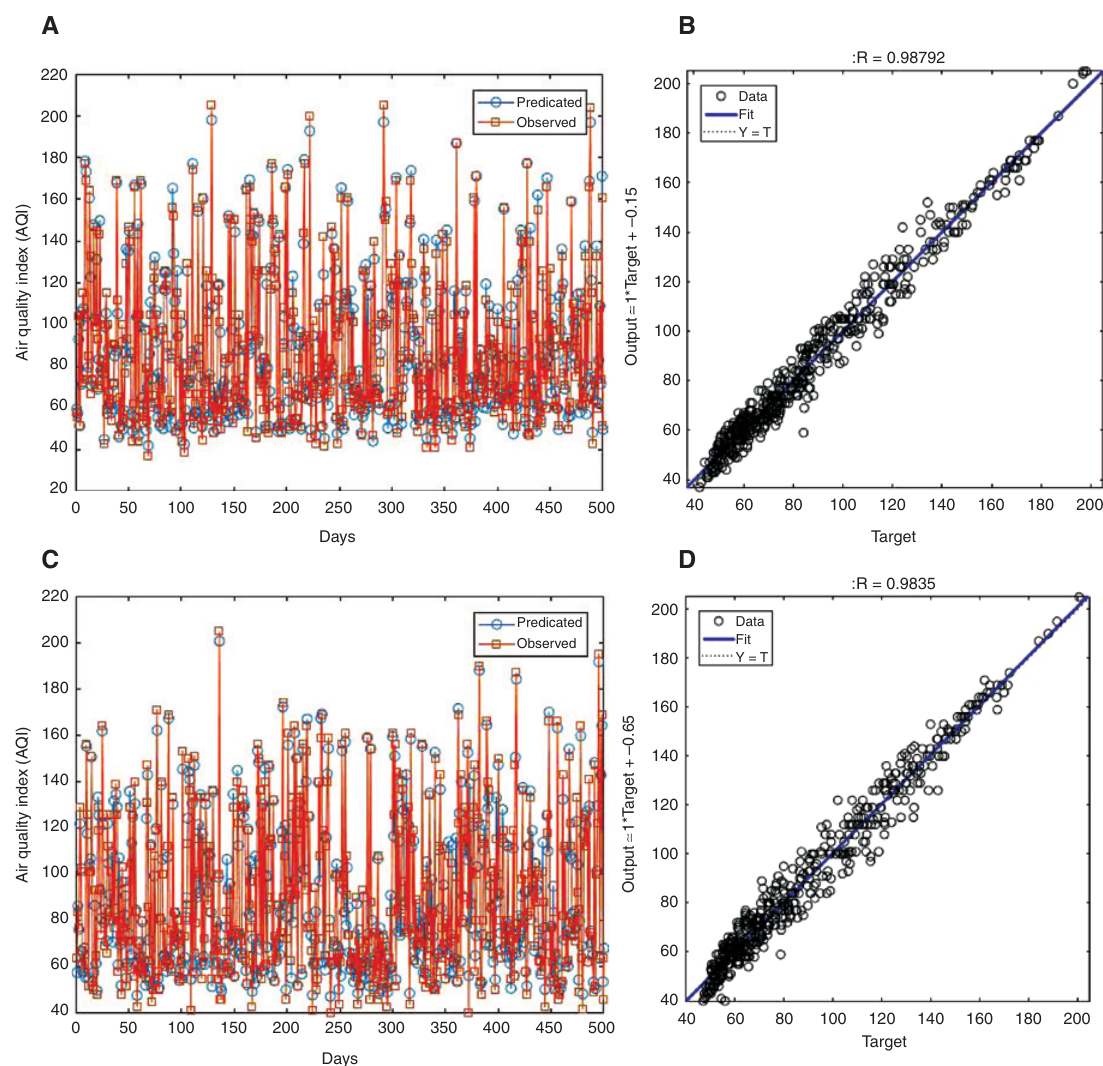
Figure 5: Cascade Forward Ensemble of Regression Models: (A) Testing Plot for Houston, (B) Regression Plot for Houston, (C) Testing Plot for Los Angeles, and (D) Regression Plot for Los